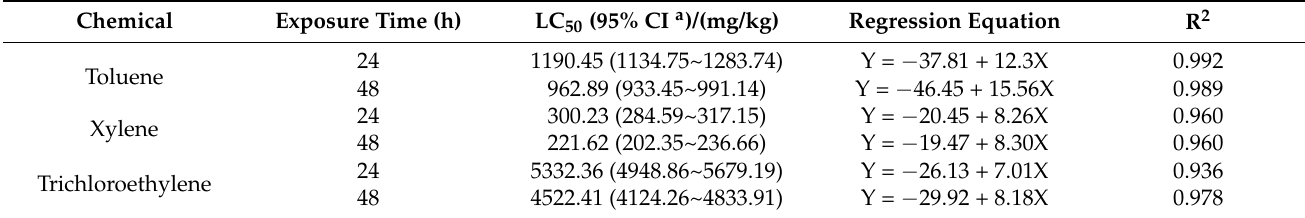
Table 2. The acute toxicity of toluene, xylene, and trichloroethylene to E. fetida . Chemical Exposure Time